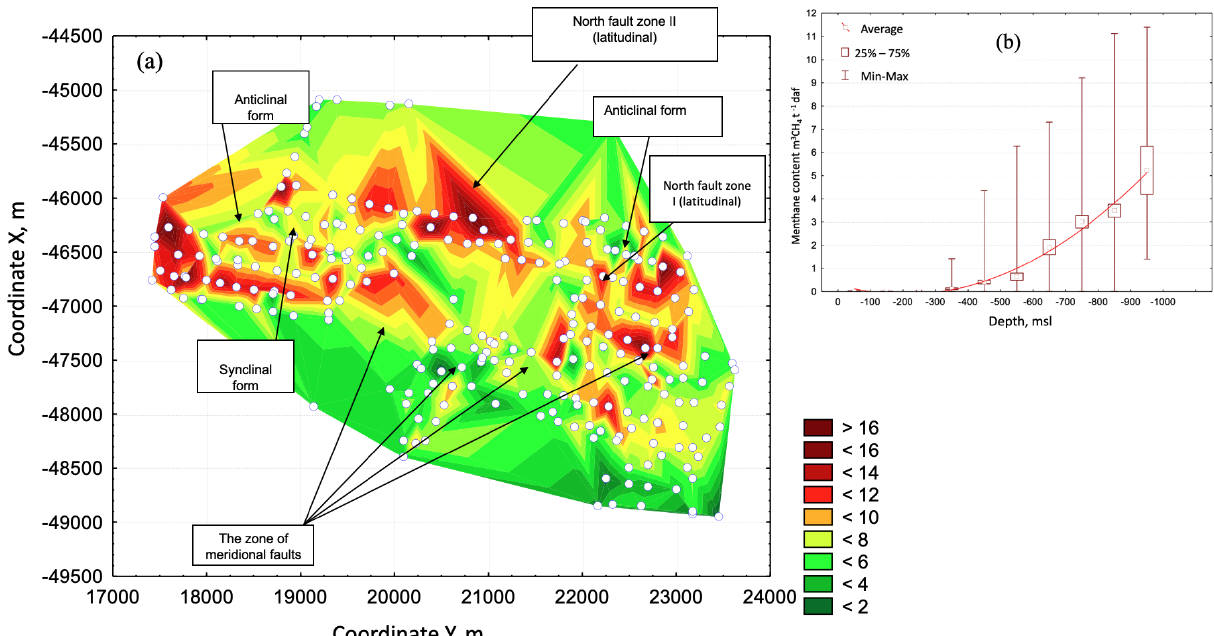
Figure 2. Methane content (Mc) variability depending on depth and across the deposit exemplarily shown for the Brzeszcze coal mine. (a) Wafer chart of the methane content isolines within the deposit 352 in the Brzeszcze coal mine in a two-dimensional space with marked disturbances of the geological structure. White dots indicate methane content measurement points. The disorders observed based on the geological structure of the deposit are described in square boxes; x and y are the coordinates. (b) Frame chart of methane content variability at individual depth intervals in the Rydułtowy coal mine with significant mean values as a midpoint. The box corresponds to the range of results from 25% to 75%, while the whiskers represent the minimum and maximum